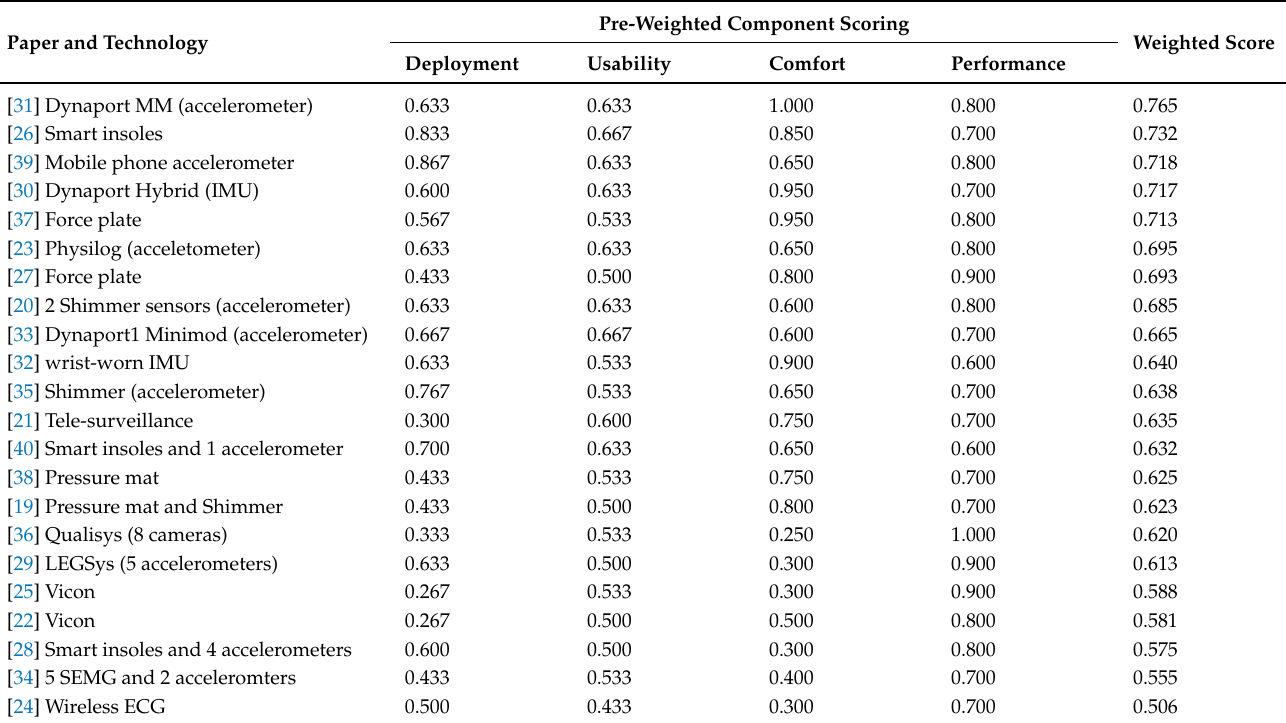
Table 3. Average Assessment